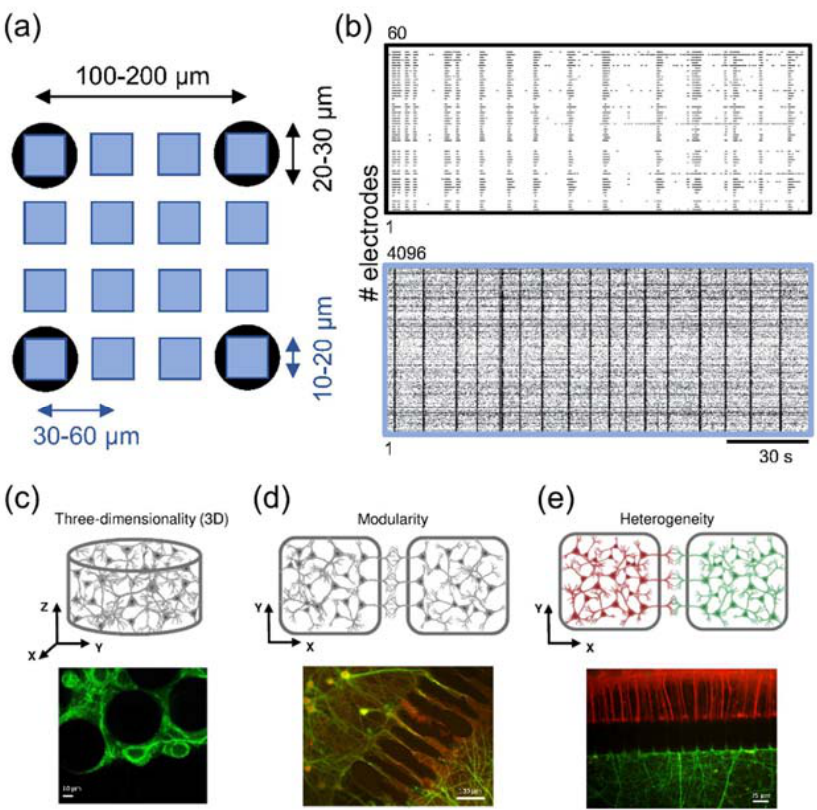
Figure 8. In vitro approaches and topological features for realistic experimental models. ( a ) High-density MEAs (blue squares) provide a higher spatial resolution of the neuronal activity than conventional solutions (black circles). The sketch shows a typical scenario where the same surface can be mapped with 16 high-density microelectrodes with respect to only 4. This feature result is fundamental if many interacting neuronal population are coupled to a MEA. ( b ) Example of spontaneous cortical activity recorded by means of a 60- (top) and 4096-electrodes (bottom) MEA. In addition to the technological part, in vitro experimental models should simultaneously embed three features: ( c ) three-dimensionality connectivity (top, adapted from [123], bottom, from [124]); ( d ) modularity topology (top, adapted from [123]); ( e ) heterogeneity, i.e., the existence of different neuronal types (top, adapted from [123], bottom, from [122], where cortical (red) and thalamic (green) neurons are interconnected to realize a complex neuronal networks).